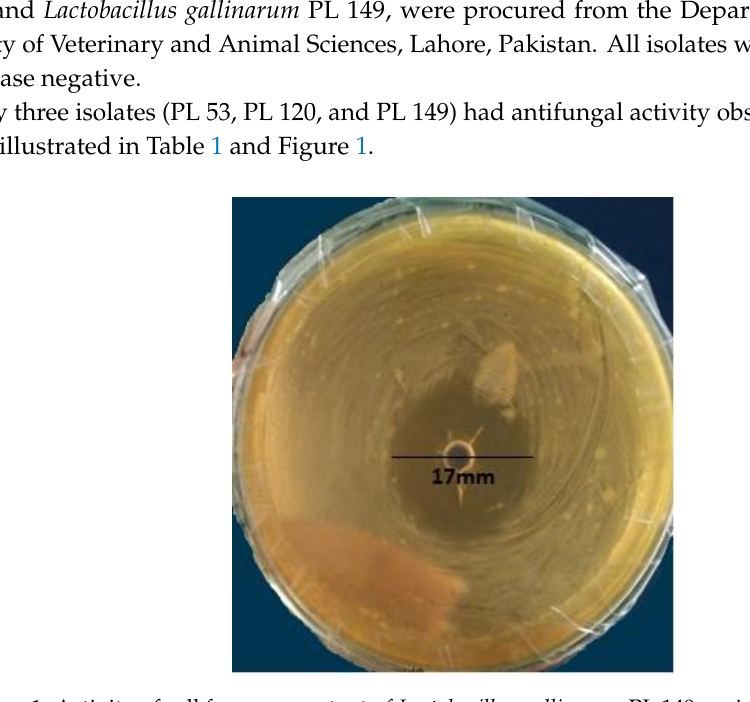
Figure 1. Activity of cell free supernatant of Lactobacillus gallinarum PL 149 against Aspergillus flavus.